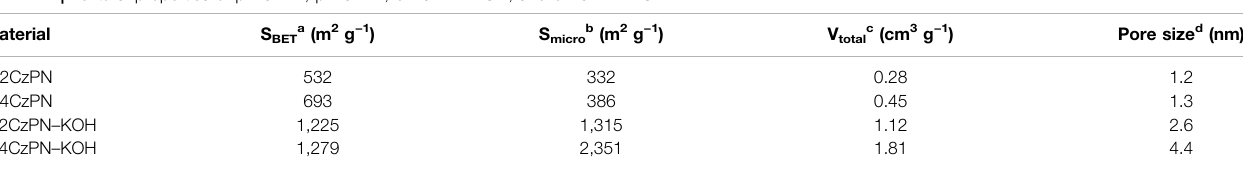
TABLE 1 | Textural properties of p-2CzPN, p-4CzPN, c-2CzPN – KOH, and c-4CzPN – KOH.